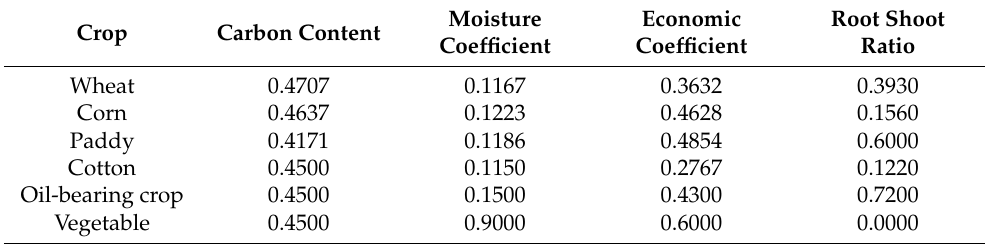
Table 3. Calculation parameters of carbon sequestration in crops.